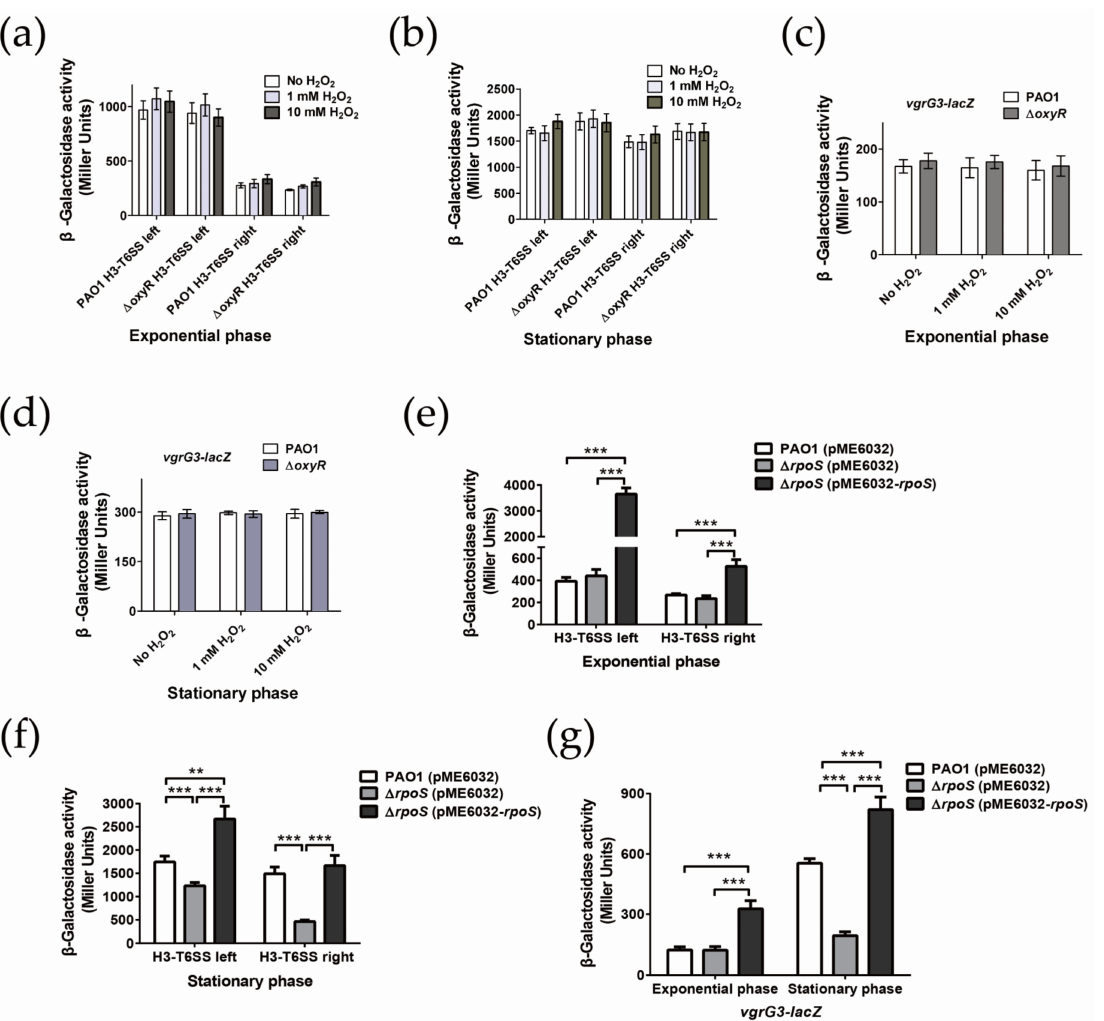
Figure 3. Expression of H3-T6SS is positively regulated by RpoS but not by OxyR. ( a – d ) β - Galactosidase analysis of the H3-T6SS promoter activity using the transcriptional H3-T6SS-left-lacZ , H3-T6SS-right-lacZ , and vgrG3-lacZ chromosomal fusion reporters expressed in the wild-type and ∆ oxyR mutant strains. The H3-T6SS and vgrG3 expressions were monitored by collecting samples exposed to the indicated concentrations of H 2 O 2 for 1 h in the logarithmic and stationary growth phases. The graph shows the mean and SD of three experiments performed in five replicates each time. ( e – g ) Expression of the H3-T6SS-lacZ and vgrG3-lacZ transcriptional fusion reporters from the PAO1 strain, its isogenic rpoS mutant, and the complementary strain ∆ rpoS (pME6032- rpoS ). The growth and β -galactosidase activity were monitored by collecting samples in the logarithmic or stationary growth phase. The graph shows the mean and SD of three experiments performed in five replicates each time. ** denotes p < 0.01, and *** denotes p <